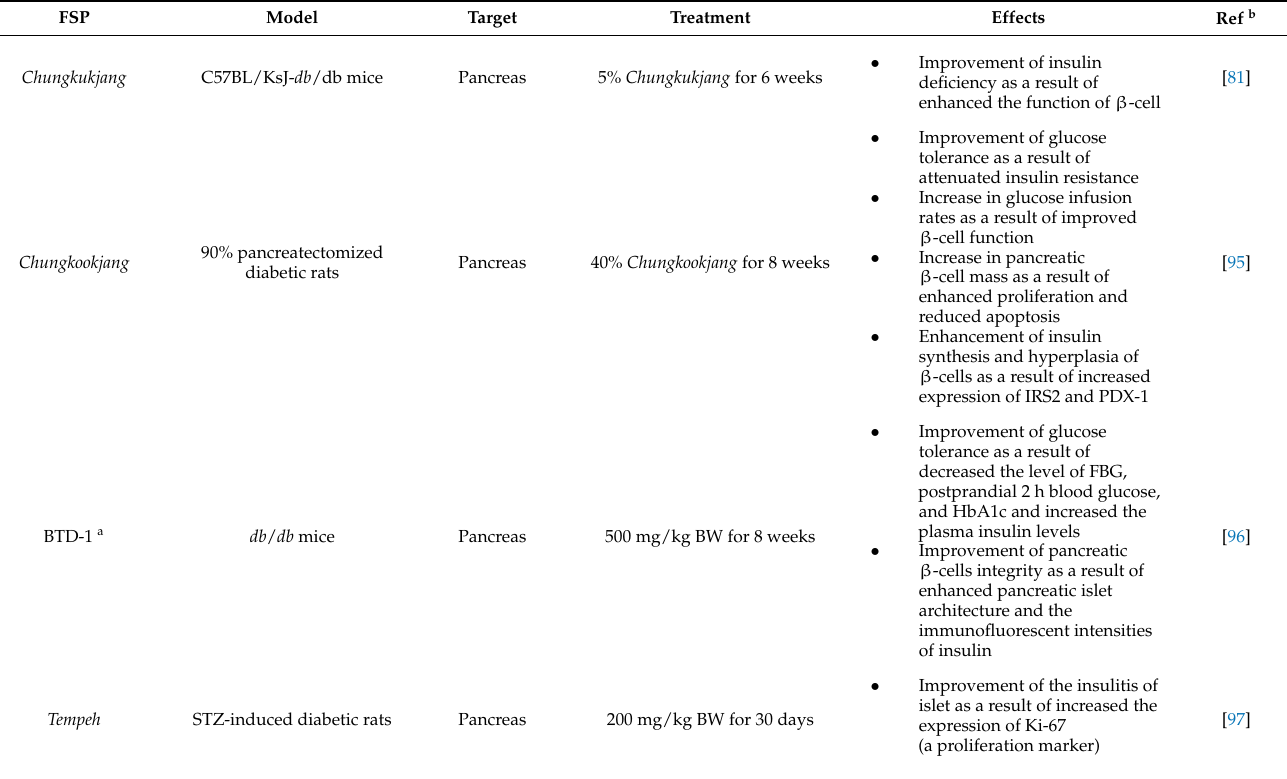
Table 6. The mechanisms of modulating the effect of FSP on glucose homeostasis in pancreatic